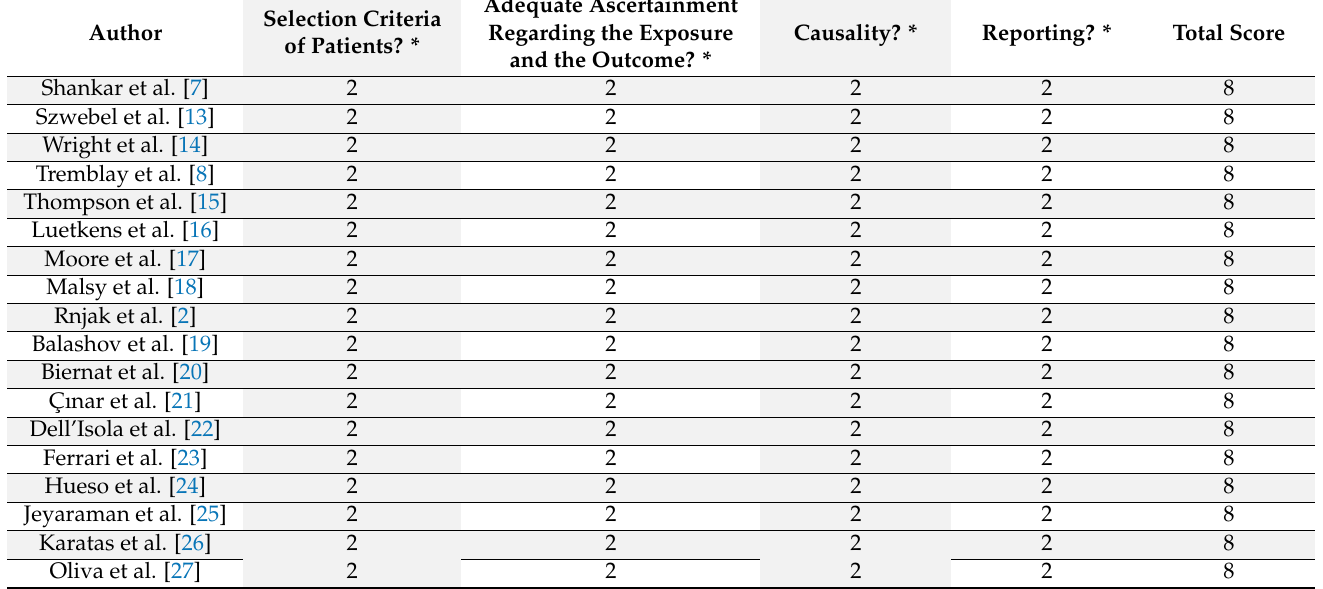
Table 1. Risk of Bias